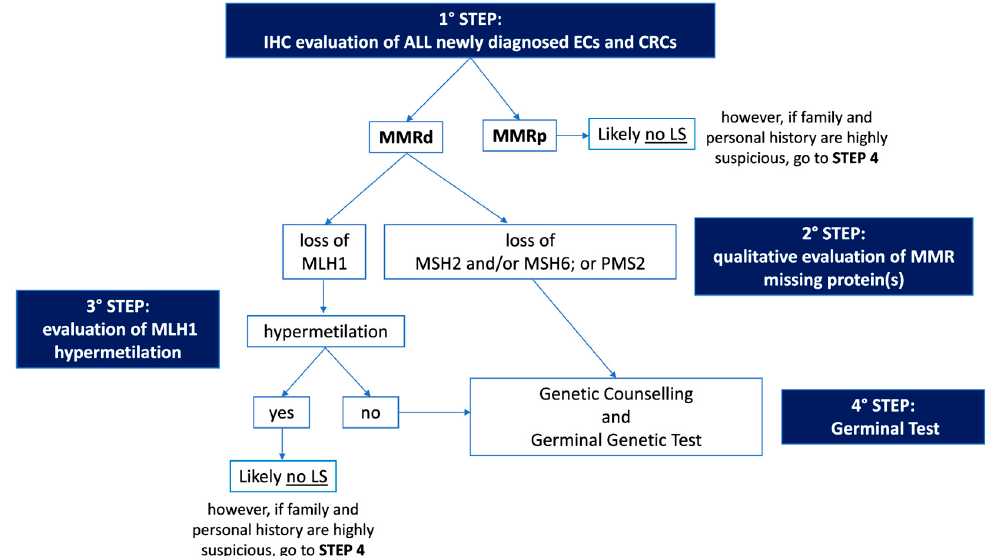
Figure 1. Flowchart for the identification of Lynch Syndrome by Universal Screening. IHC: immunohistochemistry; EC: endometrial cancer; CRC: colorectal cancer; MMRd: mismatch repair deficient; MMRp: mismatch repair proficient; LS: Lynch Syndrome.